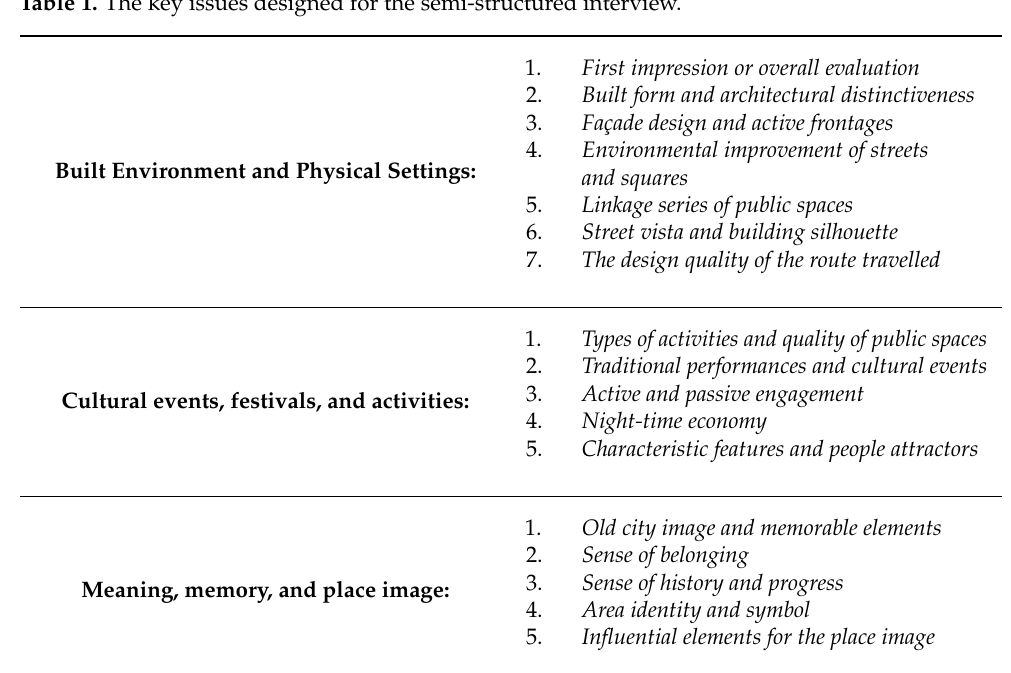
Table 1. The key issues designed for the semi-structured